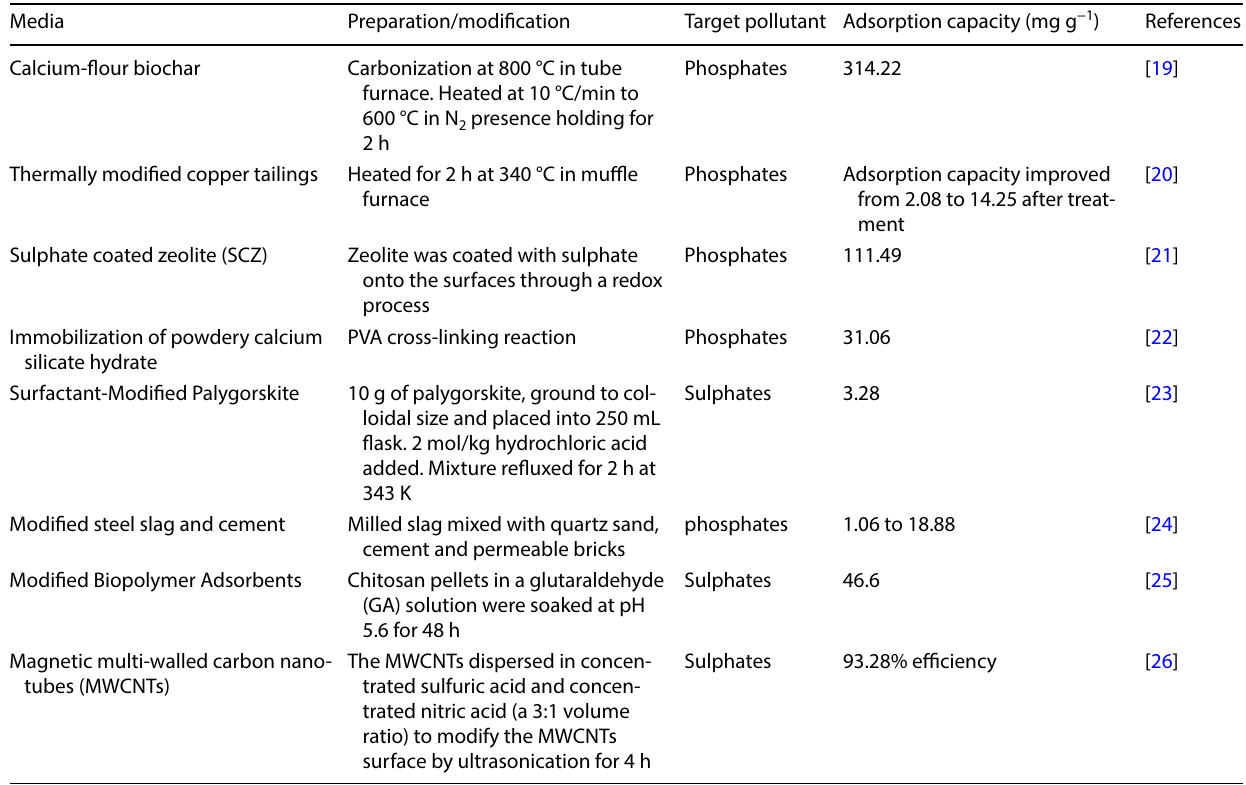
Table 1 Modifications and treatments subjected to some of the adsorbents to enhance performance